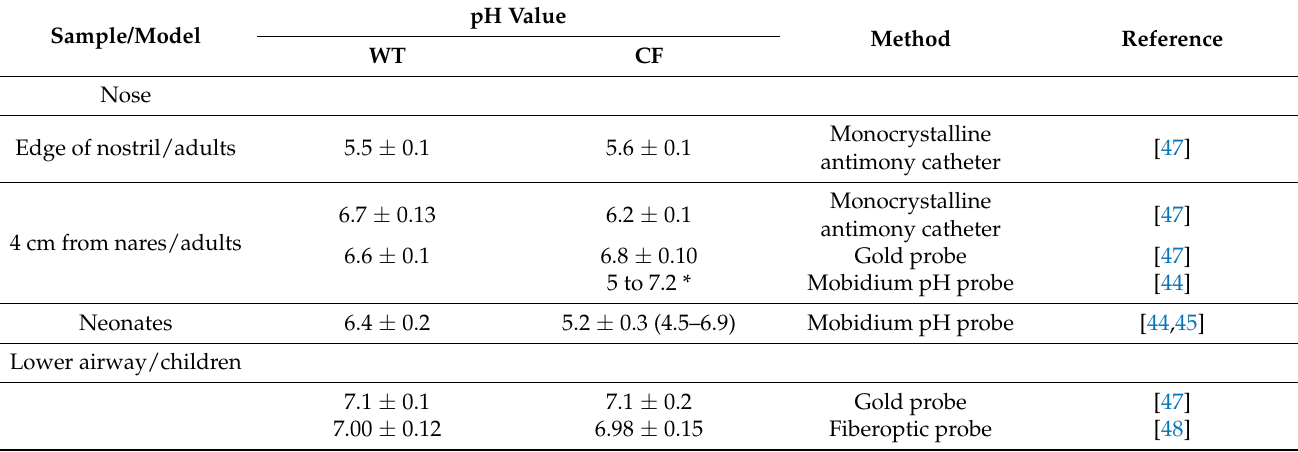
Table 3. ASL pH in vivo measurements of human samples in healthy controls and patients with cystic fibrosis. Sample/Model